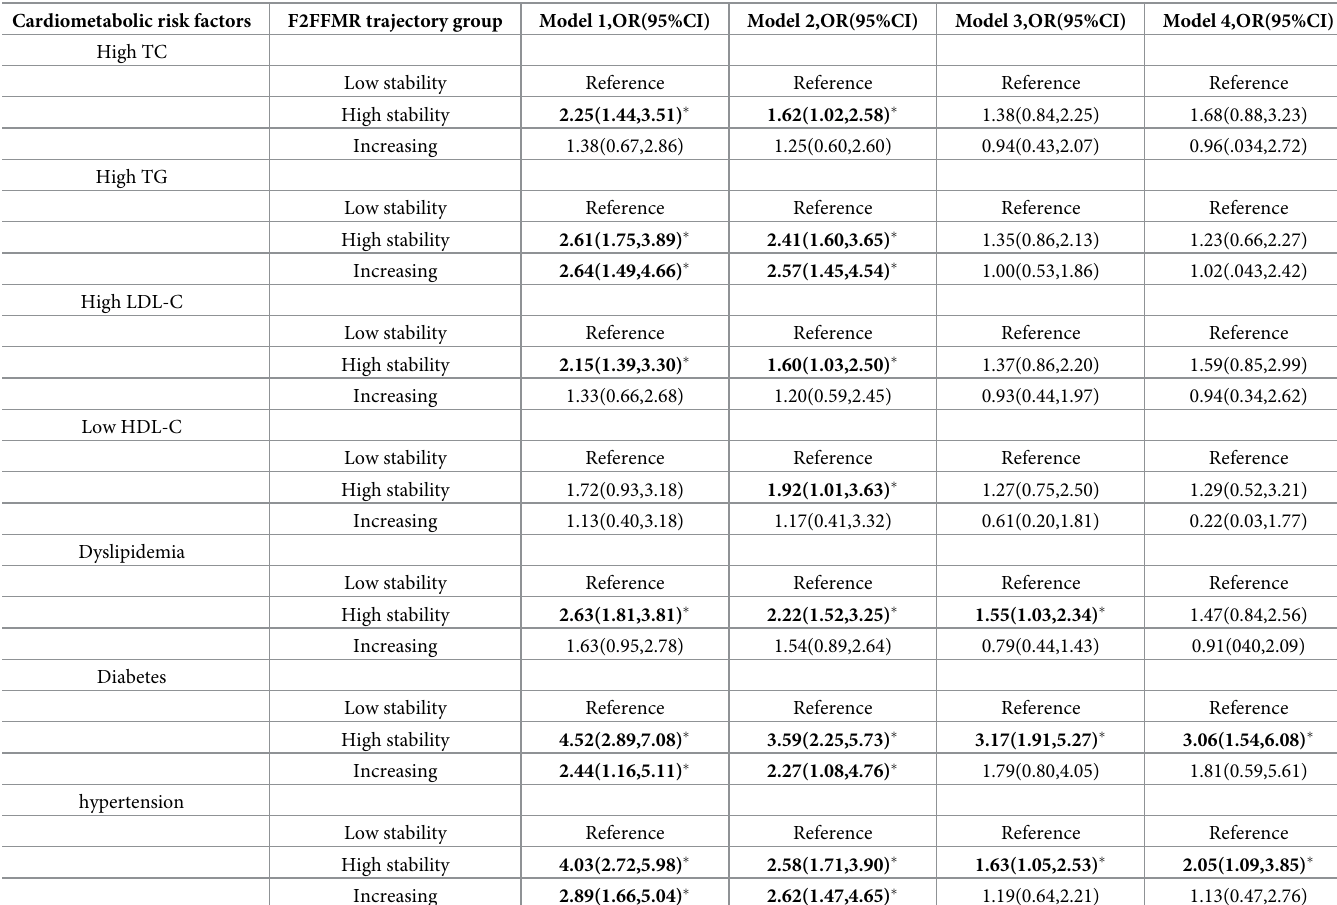
Table 5. ORs and 95% CIs for the associations between the F2FFMR trajectories of women and cardiometabolic risk factors in 2009. Cardiometabolic risk